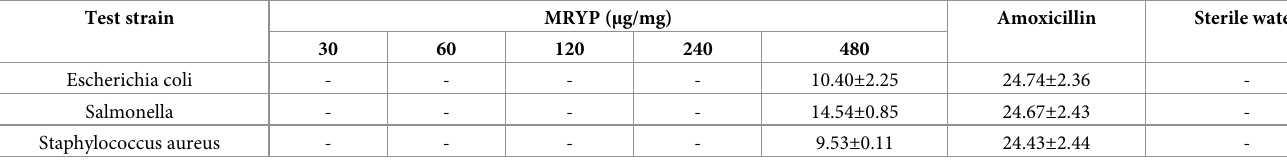
Table 8. The average diameter of the inhibition zone of 3 pathogenic bacteria (mm).